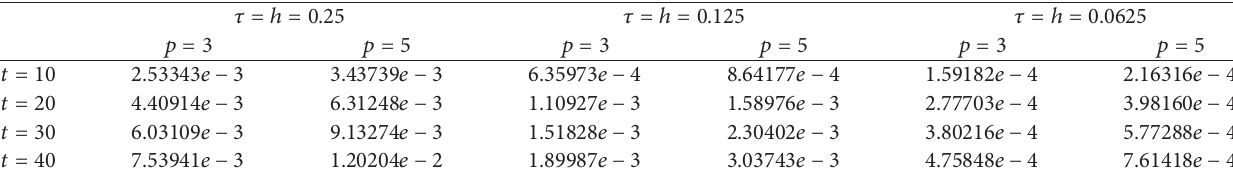
Table 1: The error at various time step.